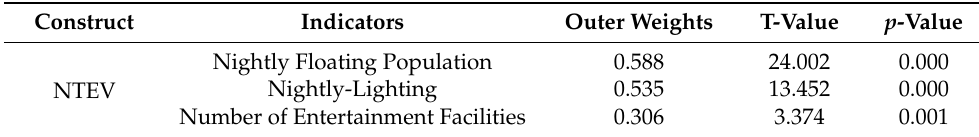
Table 5. Verification of NTEV indicators (outer